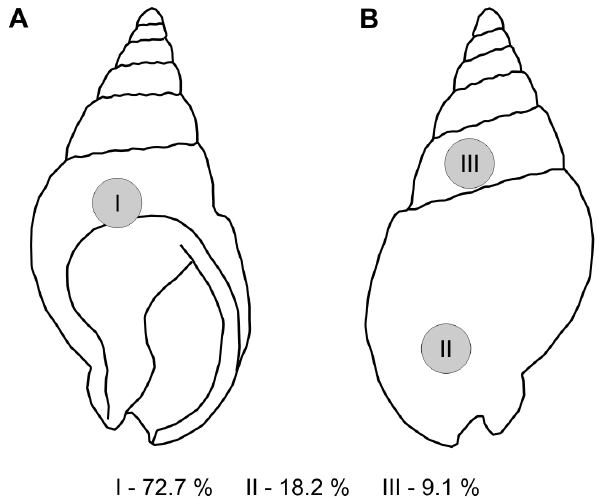
Figure 5. Frequency distribution of holes in Nassarius sp. ( A ) Apertural view. ( B ) Abapertural view.